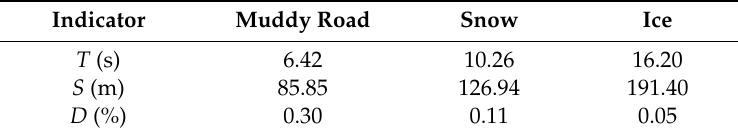
Table 6. The value of indicator in the experiments.